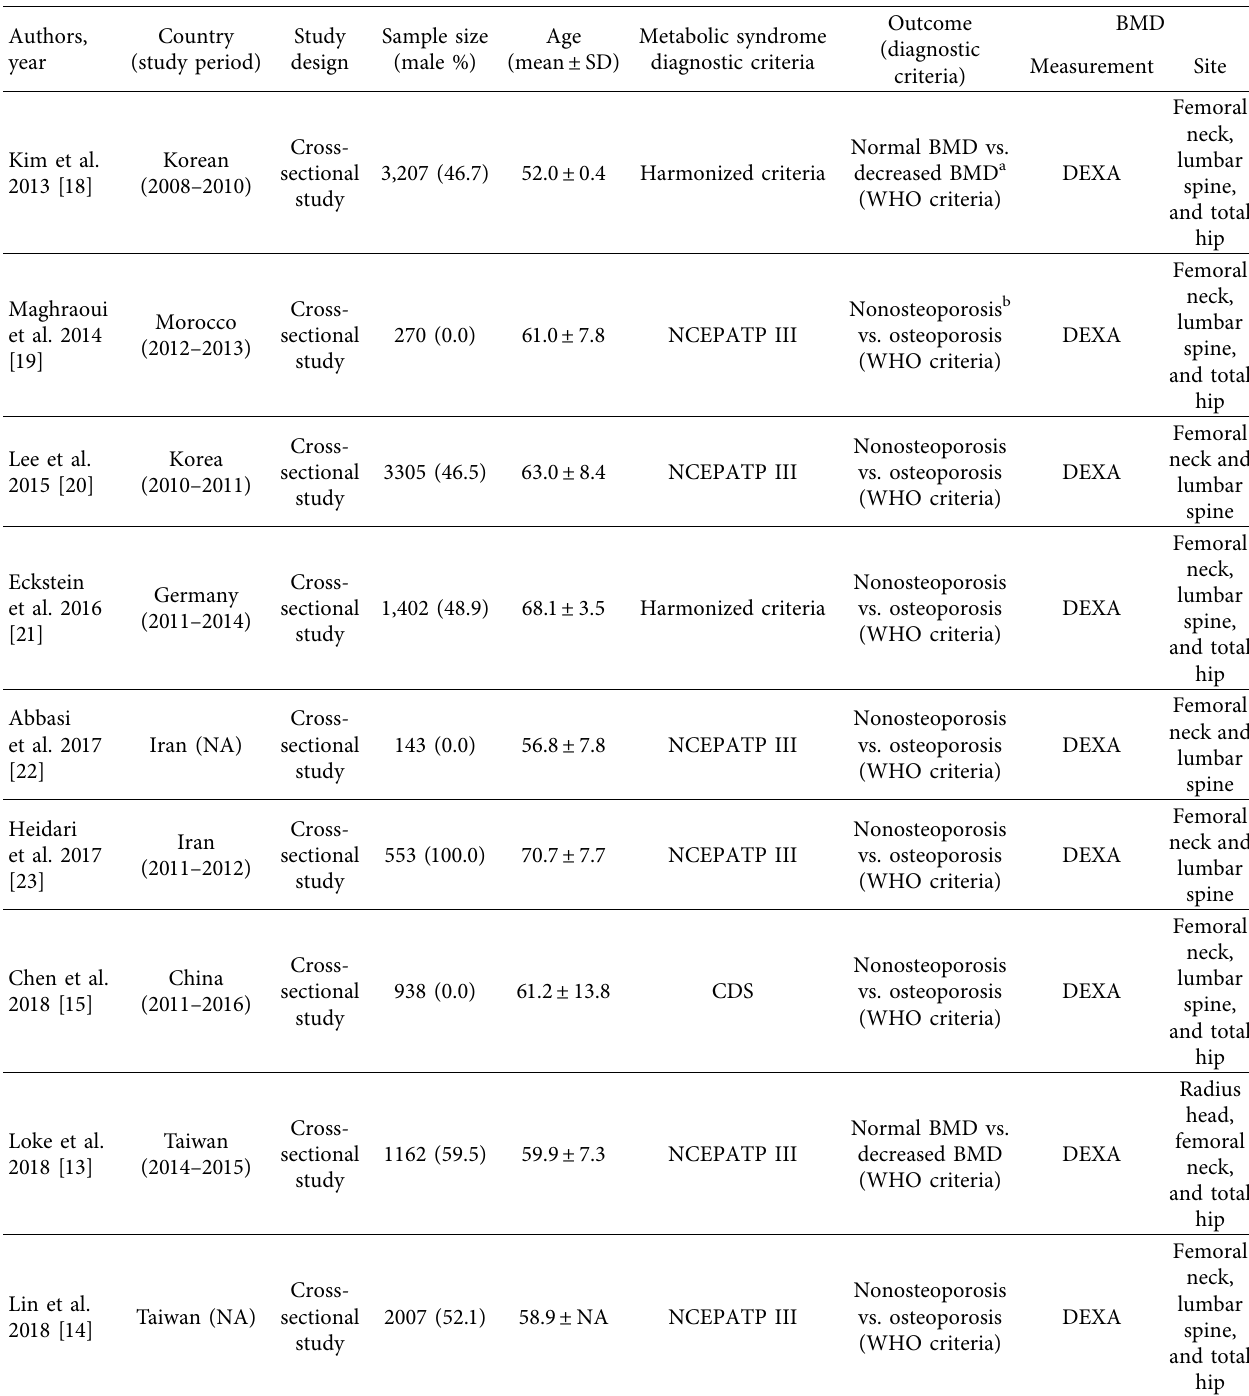
Table 1: Characteristics of included